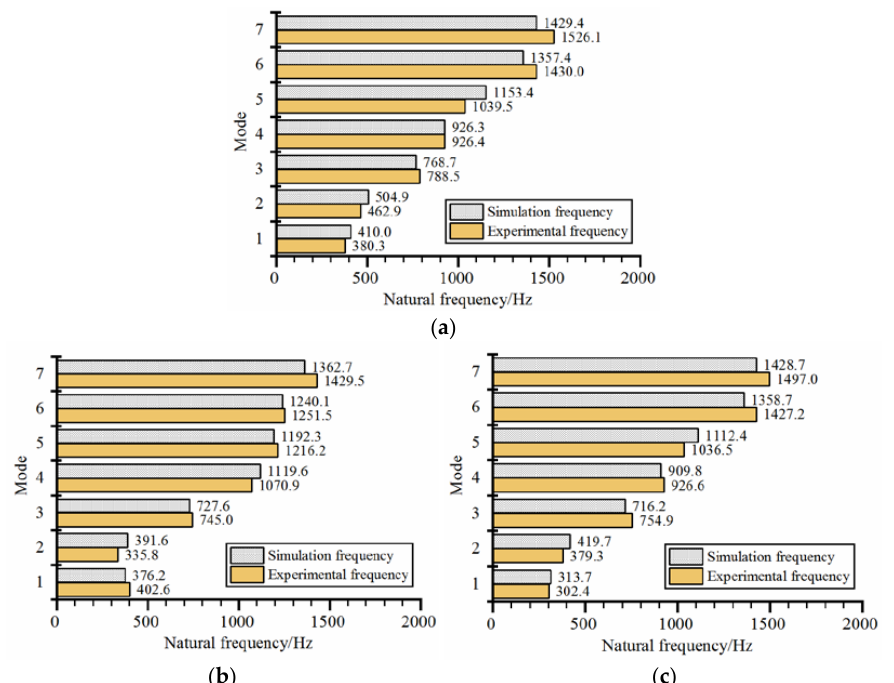
Figure 13. Natural frequency value under three working conditions. ( a ) The tool overhang length is 200 mm. ( b ) The tool overhang length is 300 mm. ( c ) The tool overhang length is 400 mm.